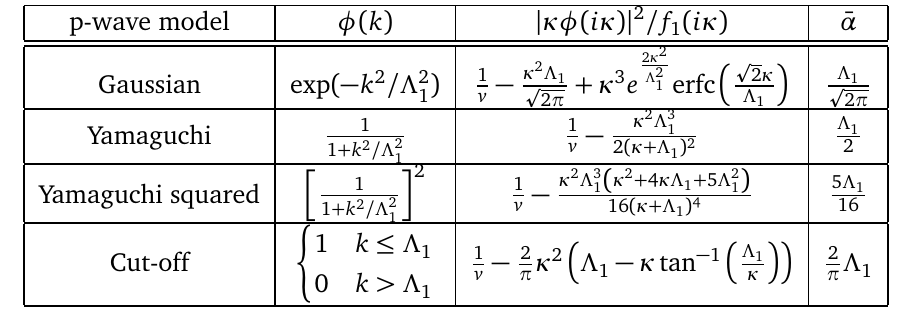
Table 2: Separable potential models used for the p-wave interaction U between the two fermions. For each model, the table provides the explicit expression of the form factor φ , the p-wave scattering amplitude f , and the width parameter¯ α 1 corresponding to the inverse of the effective range at the p-wave